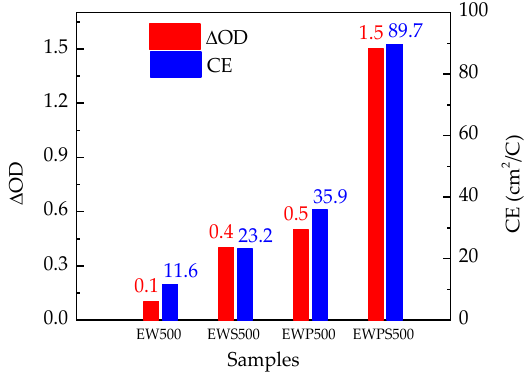
Figure 10. The optical density (∆OD) and coloration efficiency (CE) of samples EW500, EWS500, EWP500 and EWPS500.